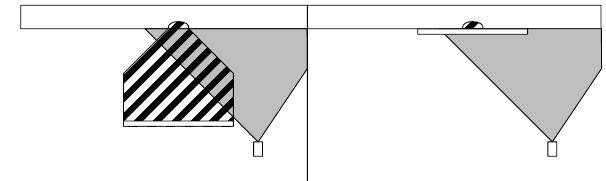
Figure 9: Left: The original scene. Right: The scene with the use of static hiding.